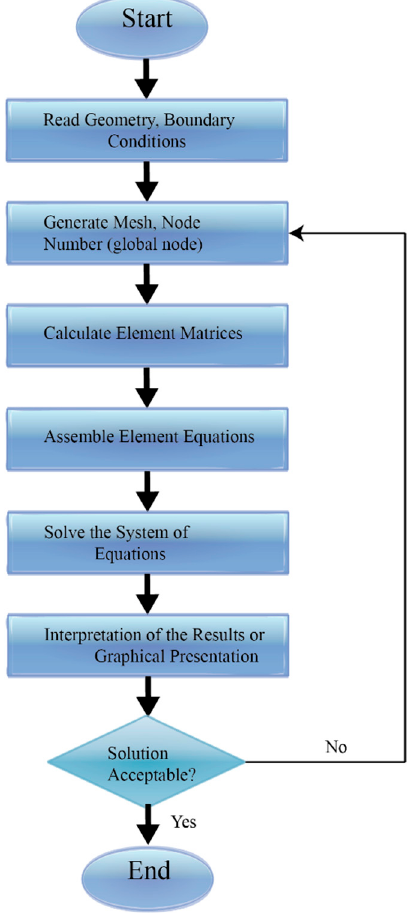
Figure 3. Flow chart of G-FEM.